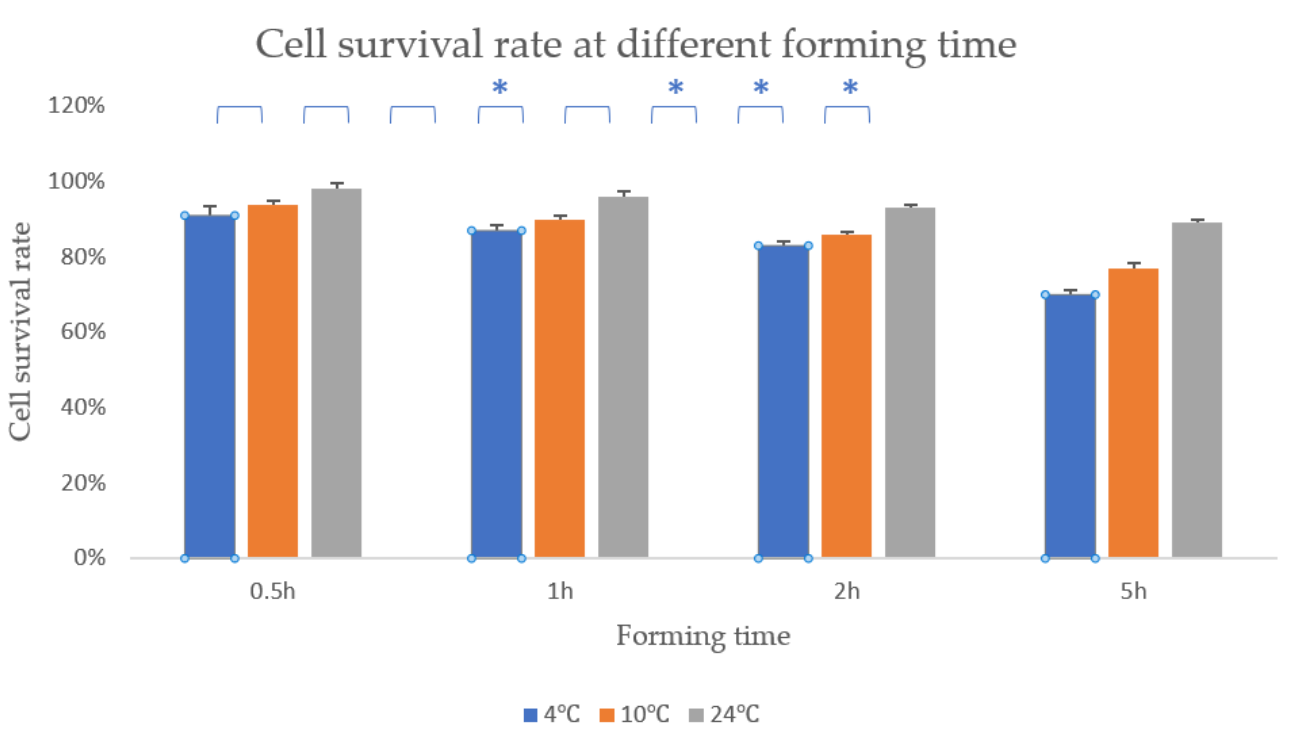
Figure 9. Cell survival rate at different forming temperature. * means that there are statistical significances between the two adjacent temperature.